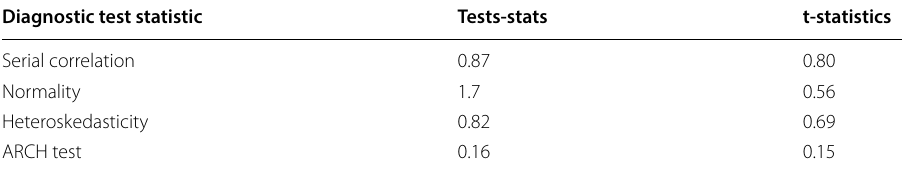
Table 6 Diagnostic tests Source : Author’s